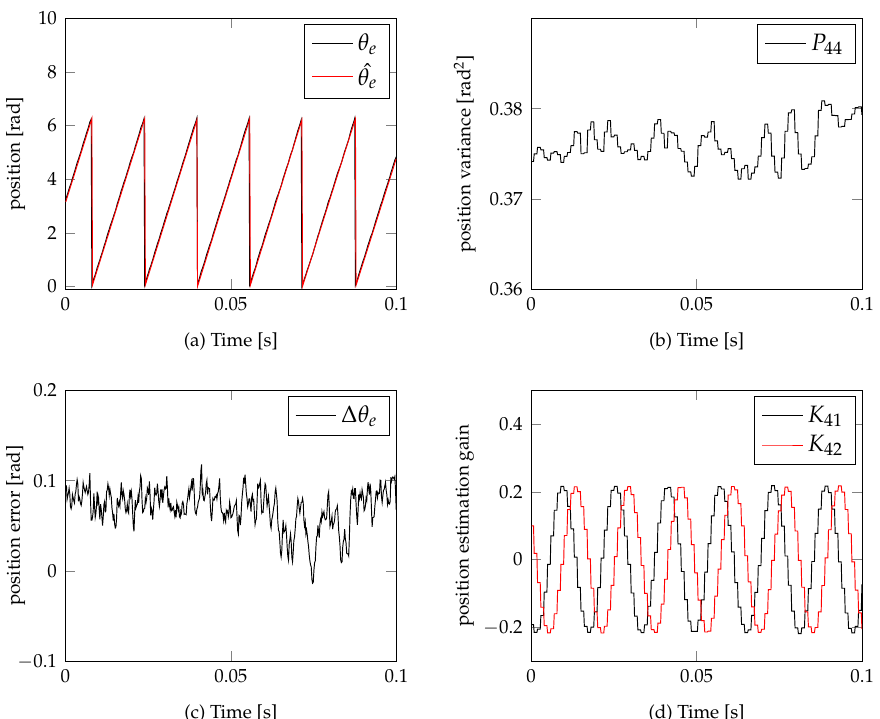
Figure 5. Simulated rotor position performance at f b = 1 kHz f s = 5 kHz and w e = 400 rads. ( a ) real and estimated rotor positions, ( b ) estimated position error, ( c ) estimated position variance, ( d ) position estimation Kalman gains.